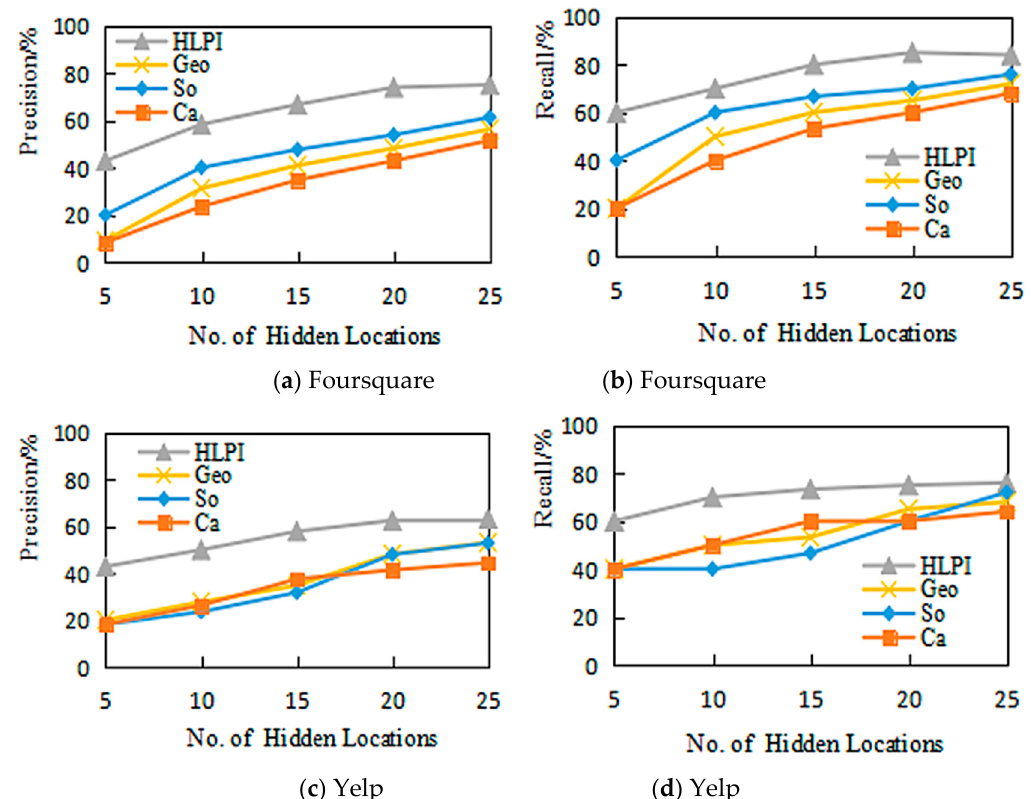
Figure 4. Prediction accuracy of HLPI with different types of background knowledge.